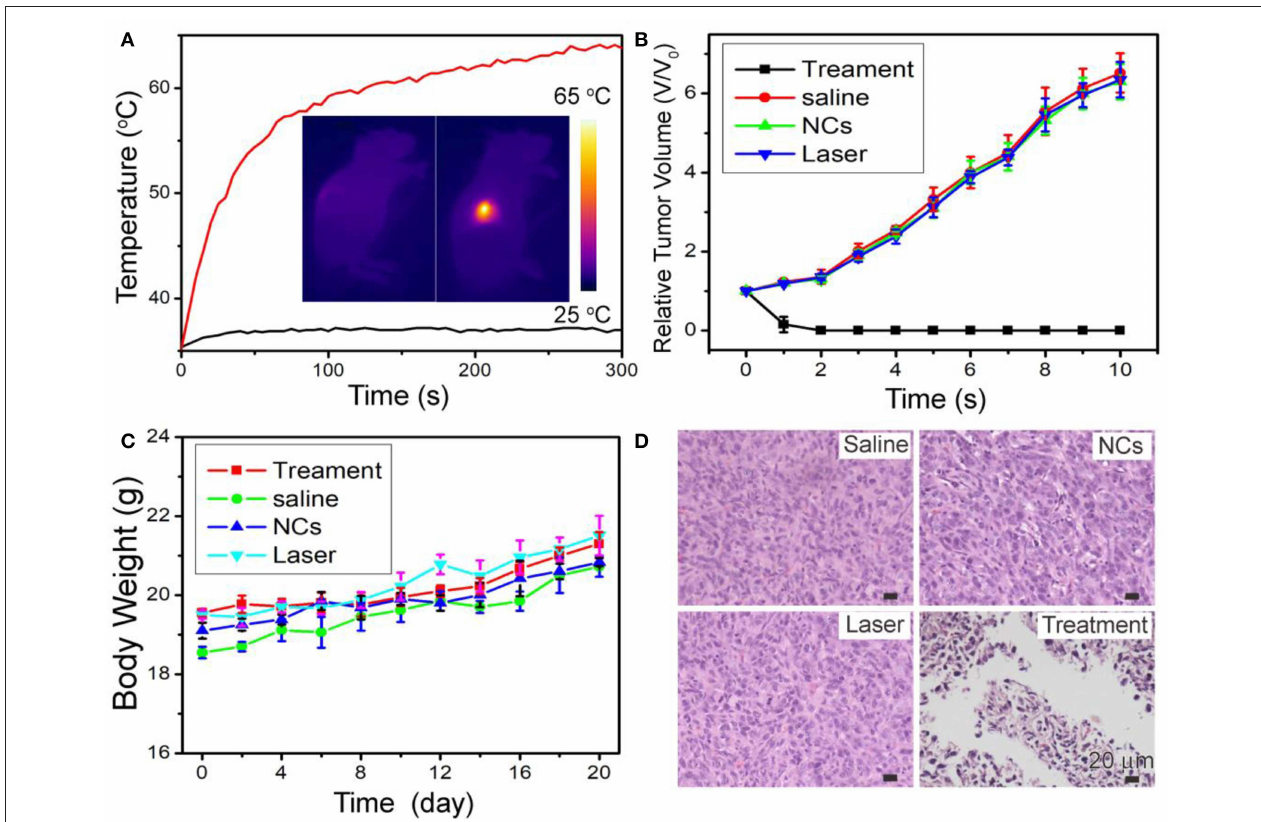
FIGURE 5 | (A) Temperature curves of tumors as a function of irradiation time. Insert: Full-body infrared thermal images of two Saos-2 tumor-bearing mice injected with saline (left) or MCO NCs (right) by intravenous injection, respectively, and irradiated with an 808-nm laser (0.7W cm − 2 ) for 5min. (B) Growth curves of tumors in the four groups after the indicated treatments. (C) Body-weight curves as a function of time in the four groups. (D) Representative H&E-stained histological images of the tumor sections after the indicated treatments.